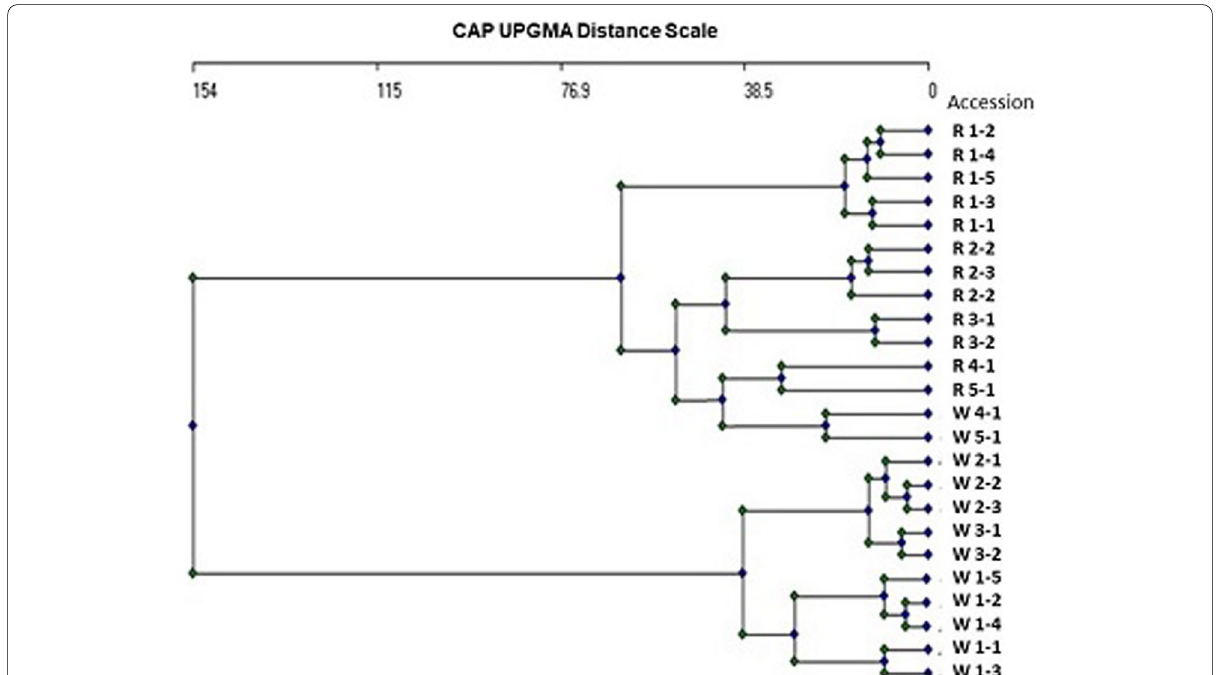
Fig. 2 Genetic diversity among wild accessions and their regenerated genotypes expressed as a CAP average linkage tree based on hierarchical grouping function